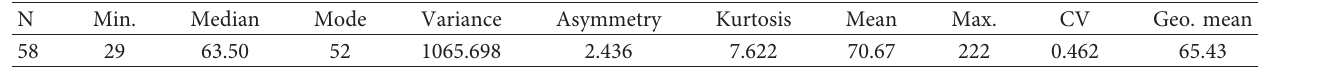
Table 6: Descriptive measures of the Data Set I.